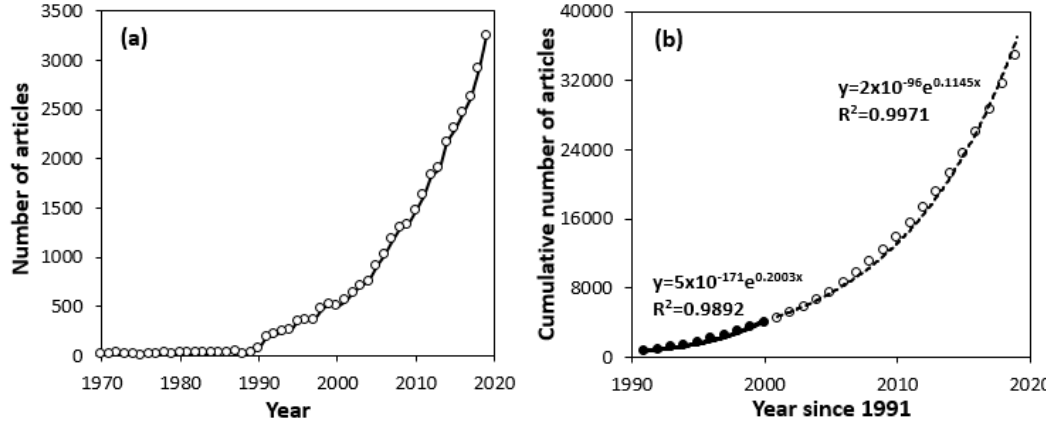
Figure 2. Publication patterns and modelled characteristics of papers addressing river and lake restoration (( a ) the number of articles from 1970 to 2019; ( b ) the relationship between the cumulative number of articles and year published, since 1991).